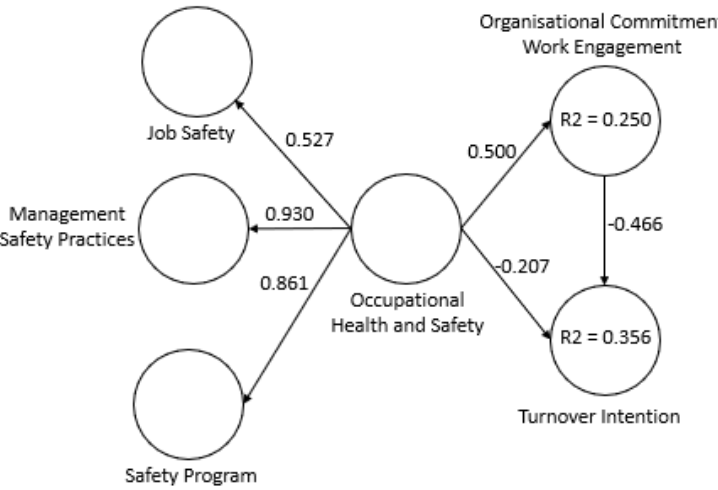
Figure 1. Structural equation model.